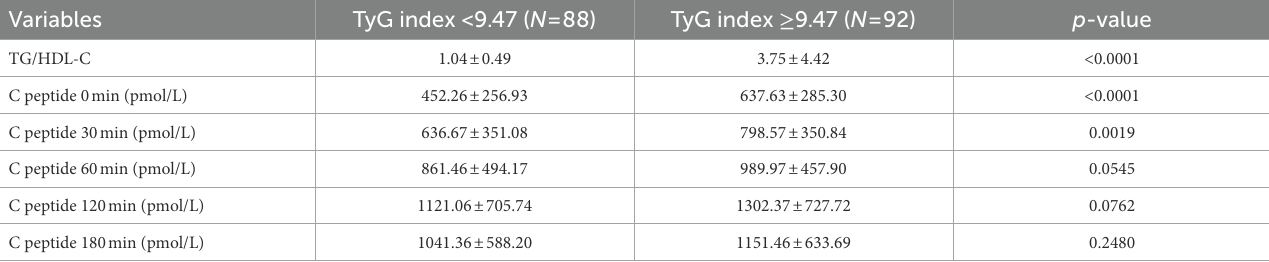
TABLE 3 Data of insulin resistance indices in T2DM patients stratified by binary TyG index.